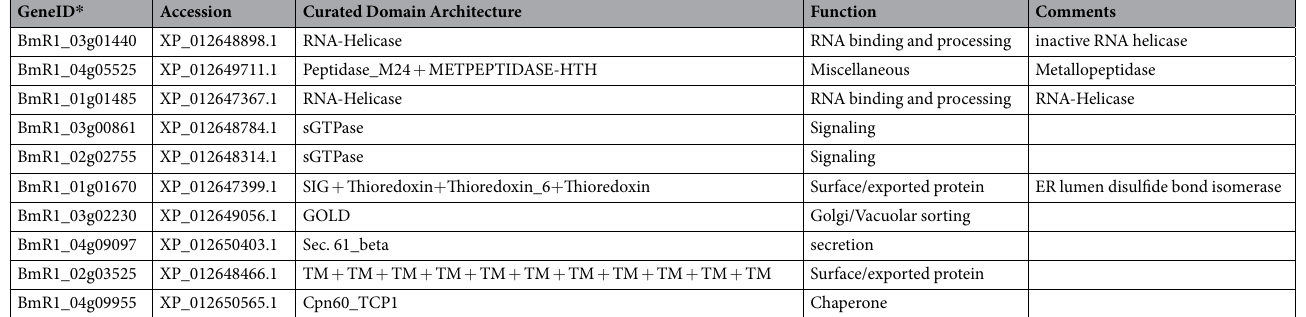
Table 1. Analysis of Babesia microti antigenic proteins. * Genes are listed based on their high, medium and low immunogenic ranking shown in Fig. 2.